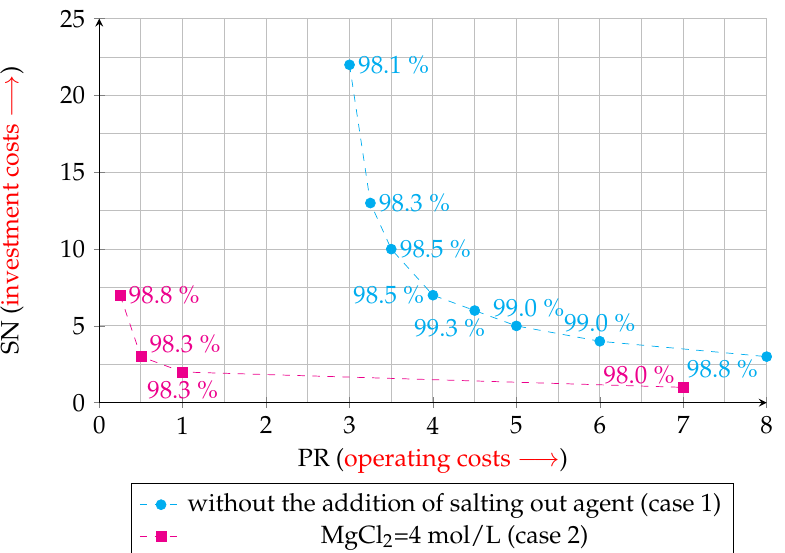
Figure 11. Relationship between the phase ratio (PR) and the stage number (SN) for solvent extraction of boric acid for case 1 and 2.